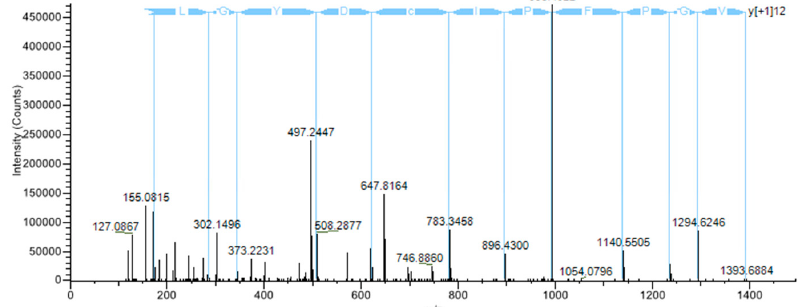
Figure 3. MS/MS spectra of purified CRP proteins after in-solution tryptic digestion. Samples were analyzed using an Orbitrap Fusion™ Tribrid™ mass spectrometer to confirm purified proteins corresponded to CRP1 and CRP4 lacking 10xHis-SUMO tags. ( a ) CRP1; ( b ) CRP4. MS/MS analyses led to 100% and 94% sequence coverage for CRP1 and CRP4, respectively. No